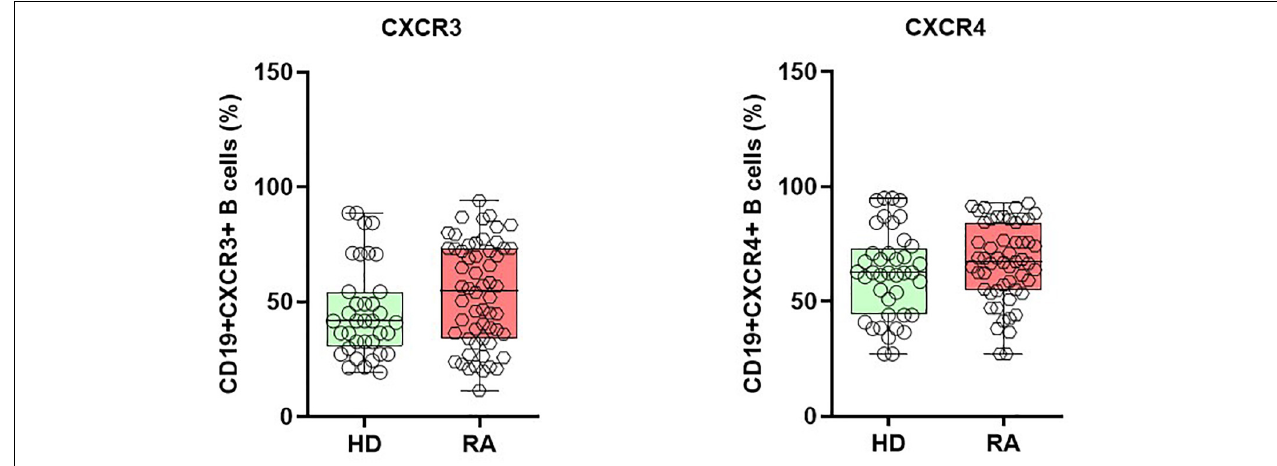
FIGURE 4 | Enhanced expression of chemokine receptor CXCR3 and CXCR4 on B cells during active RA. CD19+CXCR3+ and CD19+CXCR4+ expressing B cells are elevated in patients with active RA when compared with healthy donors